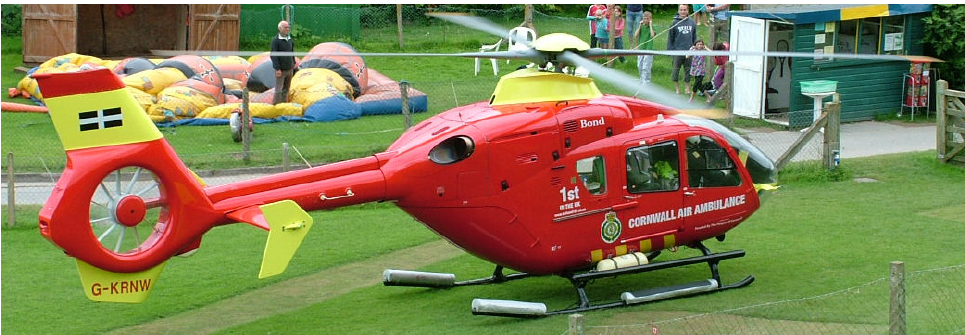
Figure 1. Eurocopter EC 135, with a fantail assembly tail rotor (reproduced from